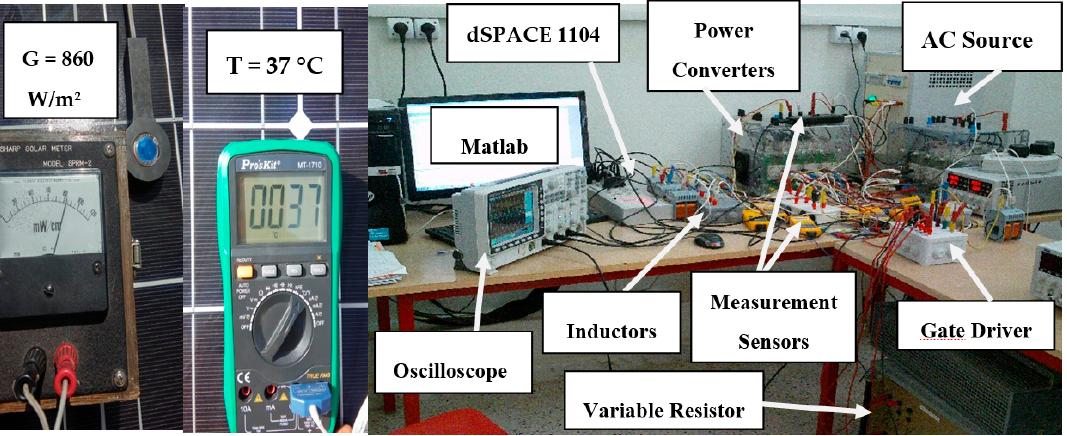
Figure 8. Experimental test bench.